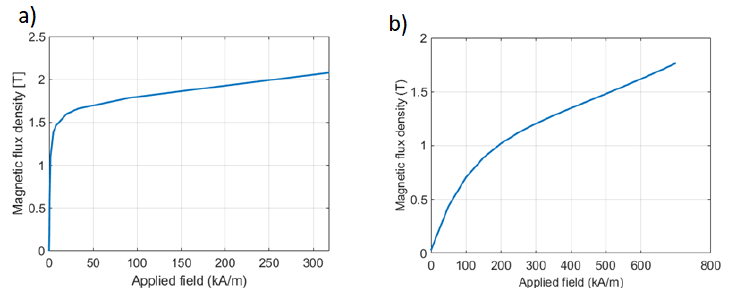
Figure 4. B-H curves for magnetic steel and MR fluid MRF-140CG. ( a ) B-H curves for